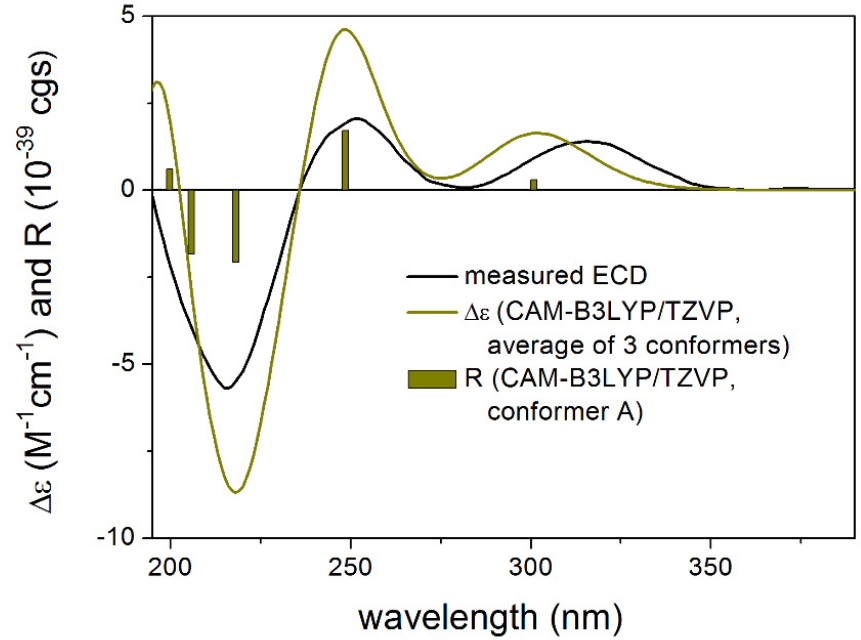
Figure 5. Experimental ECD spectrum of 1 in MeOH compared with the Boltzmann-weighted CAM-B3LYP/TZVP SMD/MeOH ECD spectrum of proposed (5 R ,6 S ,8 R ,11 R )- 1 computed for the SOGGA11-X/TZVP SMD/MeOH conformers. Bars represent the rotational strength values of conformer A.